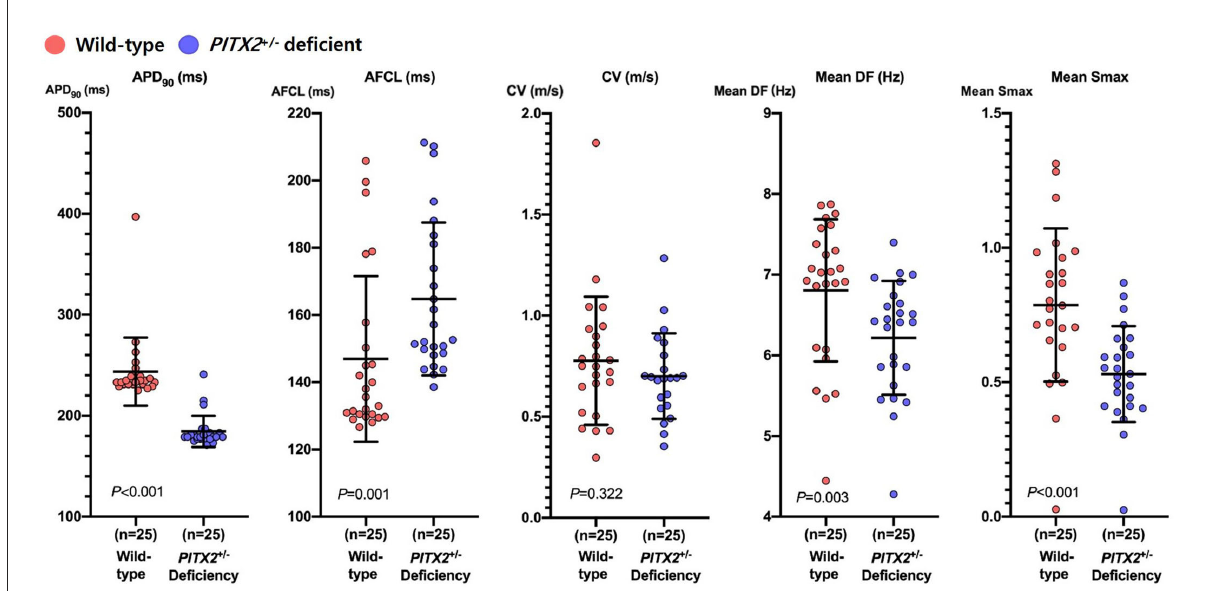
FIGURE2 Characteristics of wild-type and PITX2 + / − deficient baseline AF. Genotype-dependent comparisons of the APD 90 , CV, mean Smax, mean DF, and AFCL depend on the baseline AF. Every group includes an identical number of samples ( n = 25). APD 90 , action potential duration 90%; CV, Conduction velocity; Smax, the Maximal slope of the restitution curves; AFCL, AF cycle length; DF, Dominant frequency; PITX2 , paired-like homeodomain transcription factor